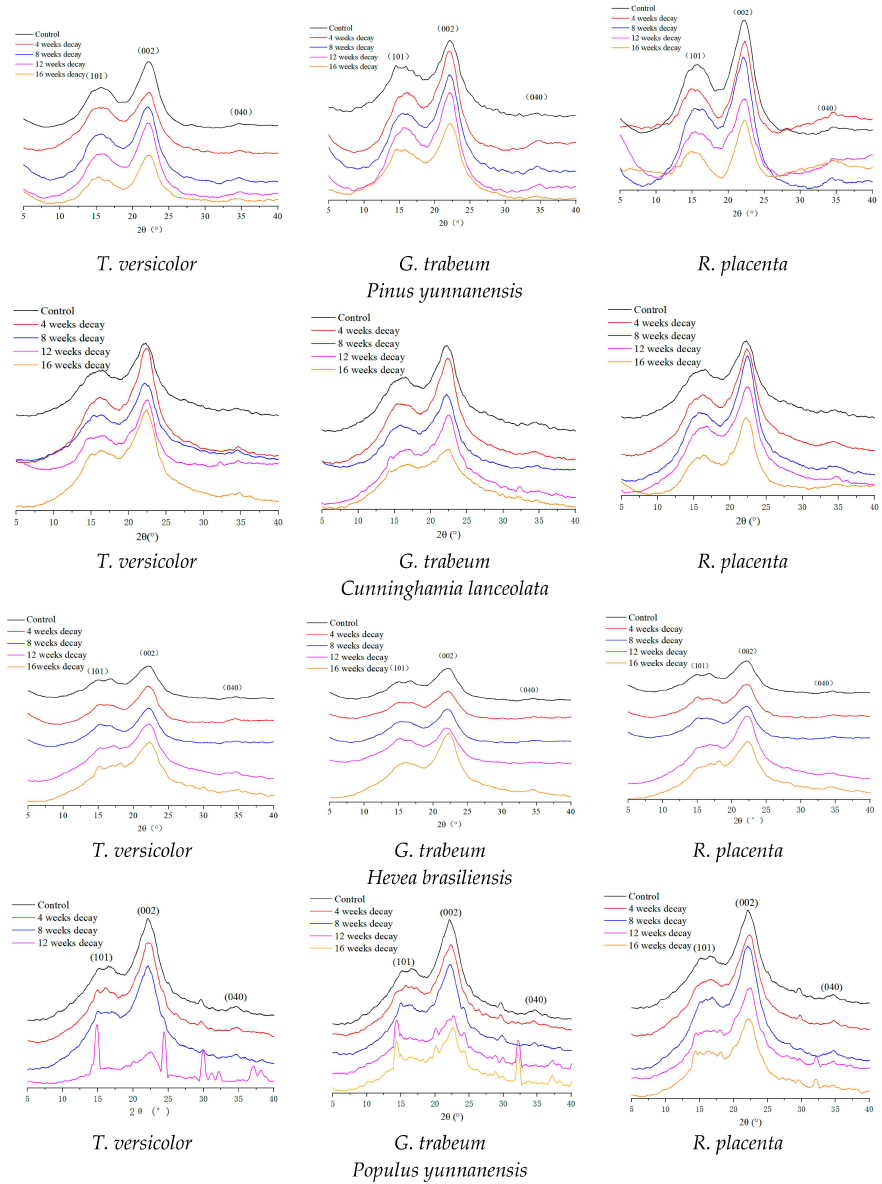
Figure 2. XRD patterns of wood samples converted by different